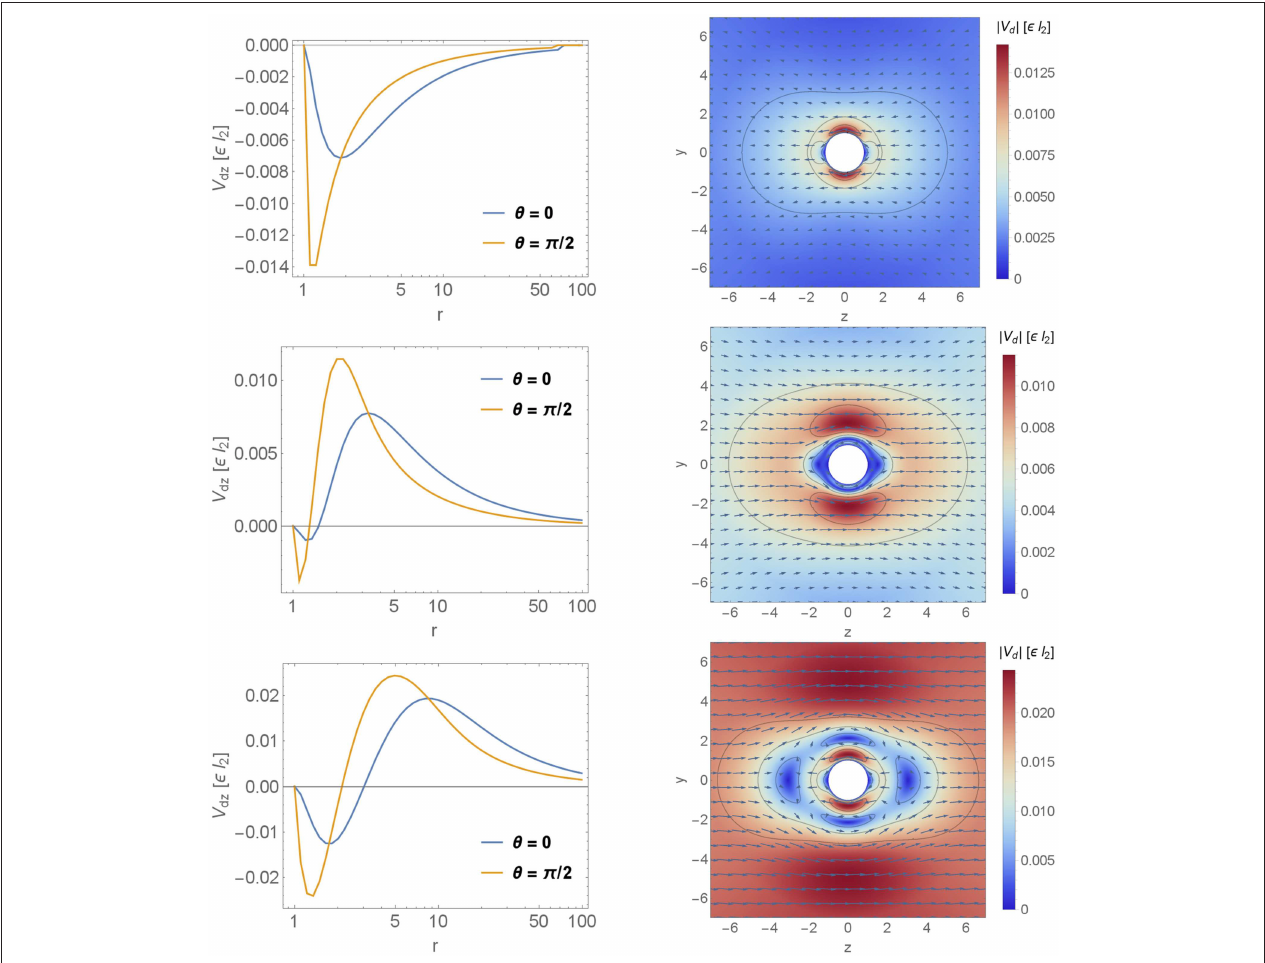
FIGURE 7 | Velocity profiles. The velocity field variation v d is shown for different decays of the viscosity variation d 2 ∈ { 0.1,1,8 } top to bottom, respectively. Each velocity field is shown in two plots. The first one is a semi-logarithmic plot which gives information about the long ranged velocity field v dz decay parallel to the symmetry axis. Therefore we calculated v dz along the lines θ = 0 and θ = π/ 2. The second one is a vector-density-plot which indicates the absolute value of | v d | and the arrows give additional information about the direction of the velocity variation. The particle is denoted by the white sphere in the middle of the plot and it is moving to the right parallel to e z